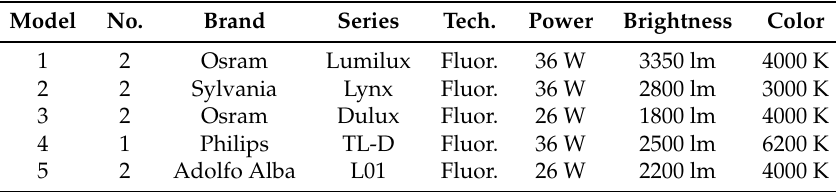
Figure 6. Lamp models in the database used in the experiments. Table 3. Characteristics of the bulbs in the lamp